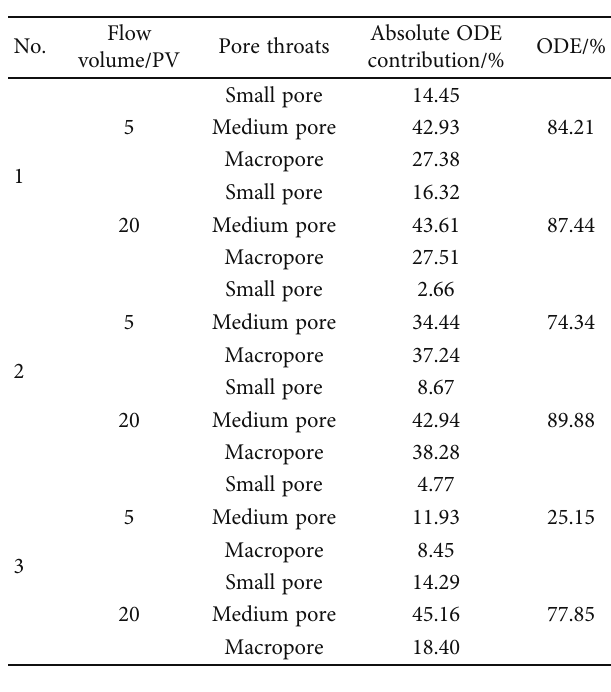
Table 2: ODE and pore proportion in di ff erent media of rock